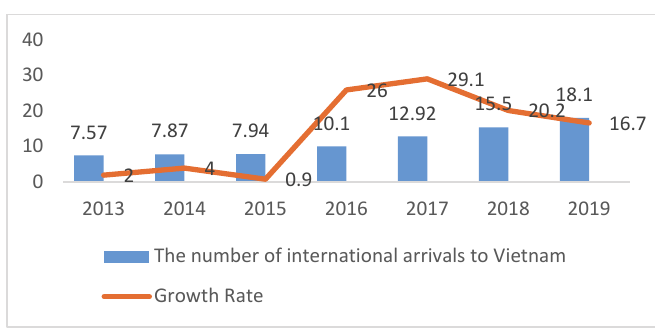
Fig. 1. Chart of international arrivals to Vietnam in the period of